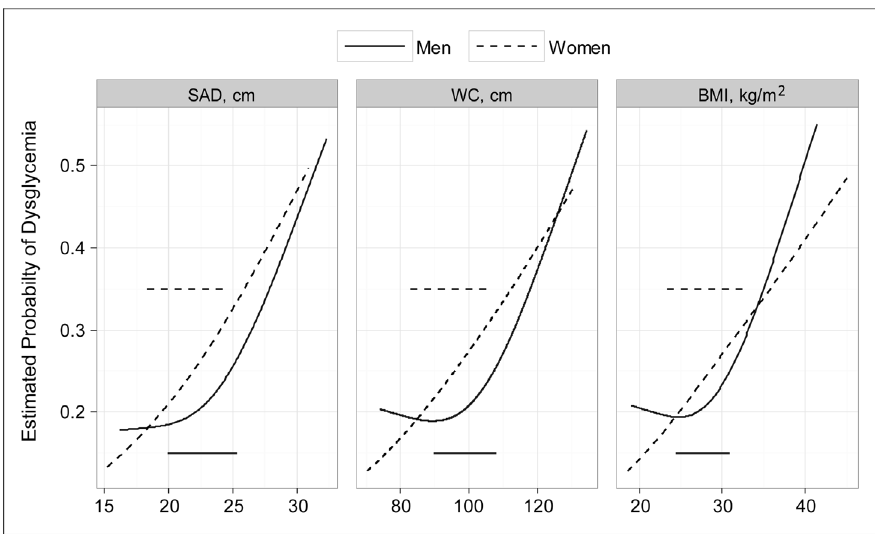
Figure 3. Probability of prevalent dysglycemia estimated by continuous sagittal abdominal diameter, waist circumference or body mass index. In these age-adjusted plots prepared by restricted cubic splines, the horizontal lines represent the interquartile range (p25 to p75) in the sex- specific population distributions of each adiposity indicator .